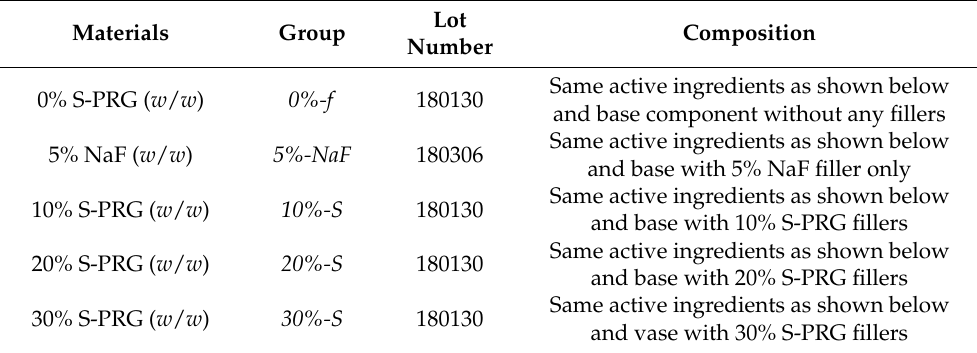
Table 1. DV preparations with their group distribution, lot numbers, and composition are